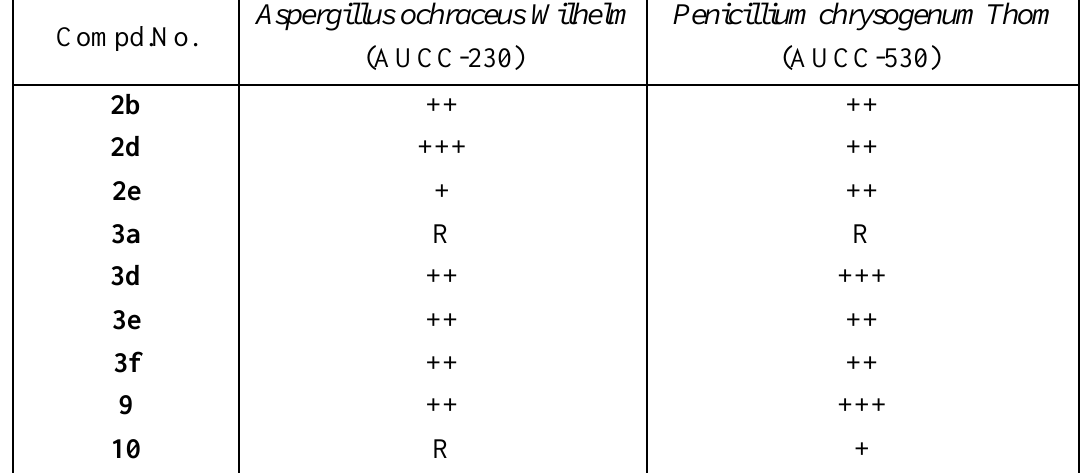
Table 2: Antifungal activity of the synthesized compounds